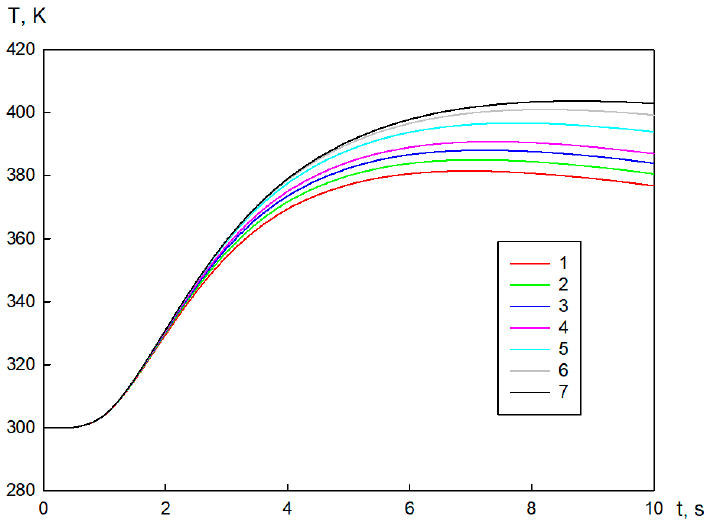
Figure 3. Temperature change over time: ∆ t = 0, d = 4.5 mm, h = 40 mm, 1—L = 140 mm, 2—L = 100 mm, 3—L = 84 mm, 4—L = 76 mm, 5—L = 68 mm, 6—L = 62 mm, 7—L = 58 mm.